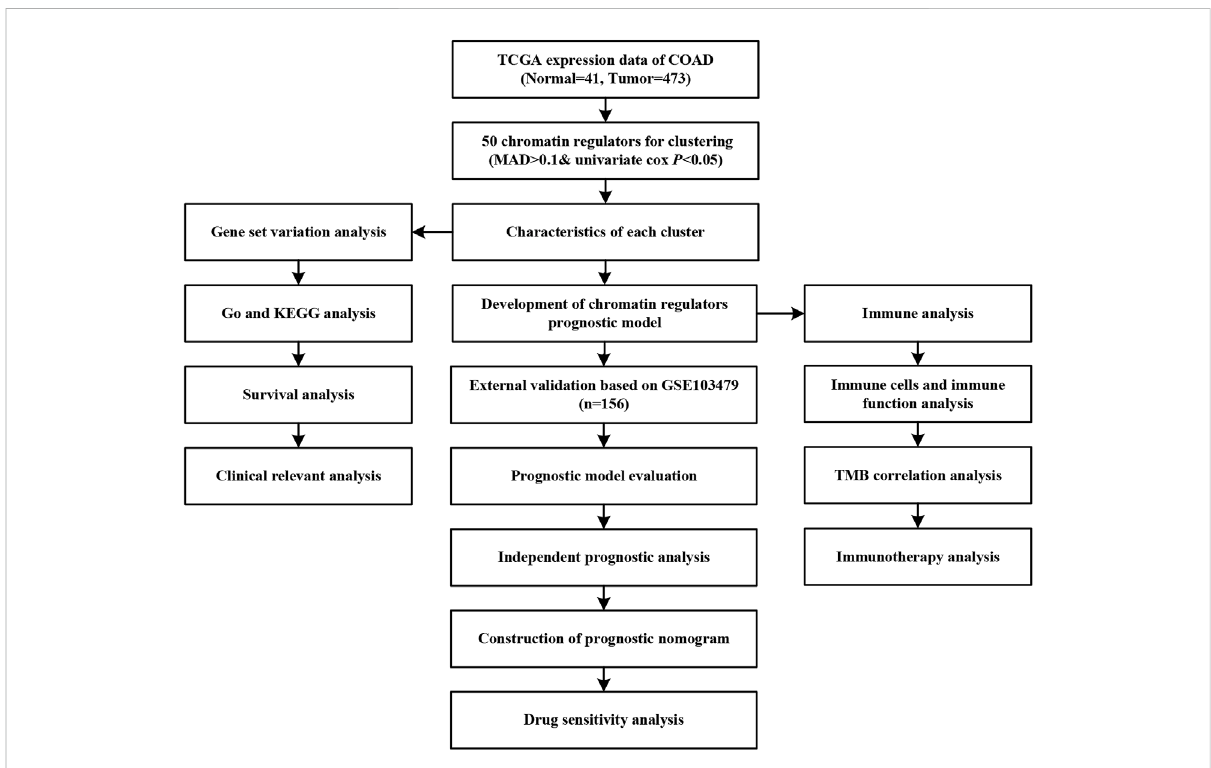
FIGURE 1 The fl ow chart of integrative